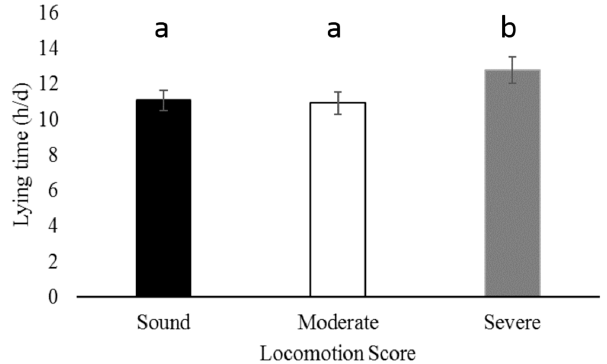
Figure 1. Severely lame cows (locomotion score = 3) had greater mean daily lying time than moderately lame cows (locomotion score = 2; p = 0.002) and sound cows (locomotion score = 1; p = 0.003). Differences between sound, moderately lame, and severely lame cows are designated by superscripts “a” and